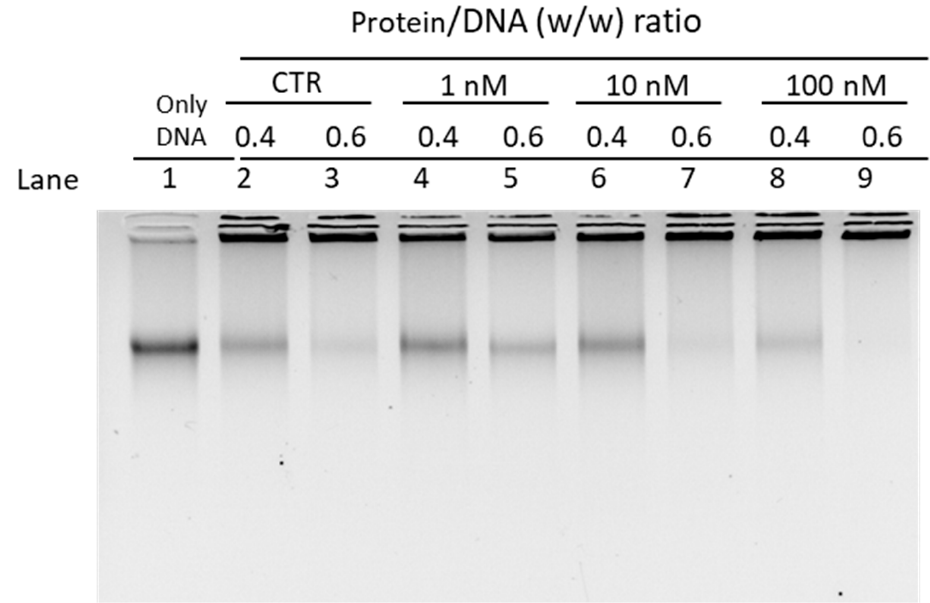
Figure 4. EMSA with sperm DNA conducted with PLs from unexposed mussels (CTR) and exposed to 1 nM, 10 nM and 100 nM chromium (VI). CTR = unexposed mussels.